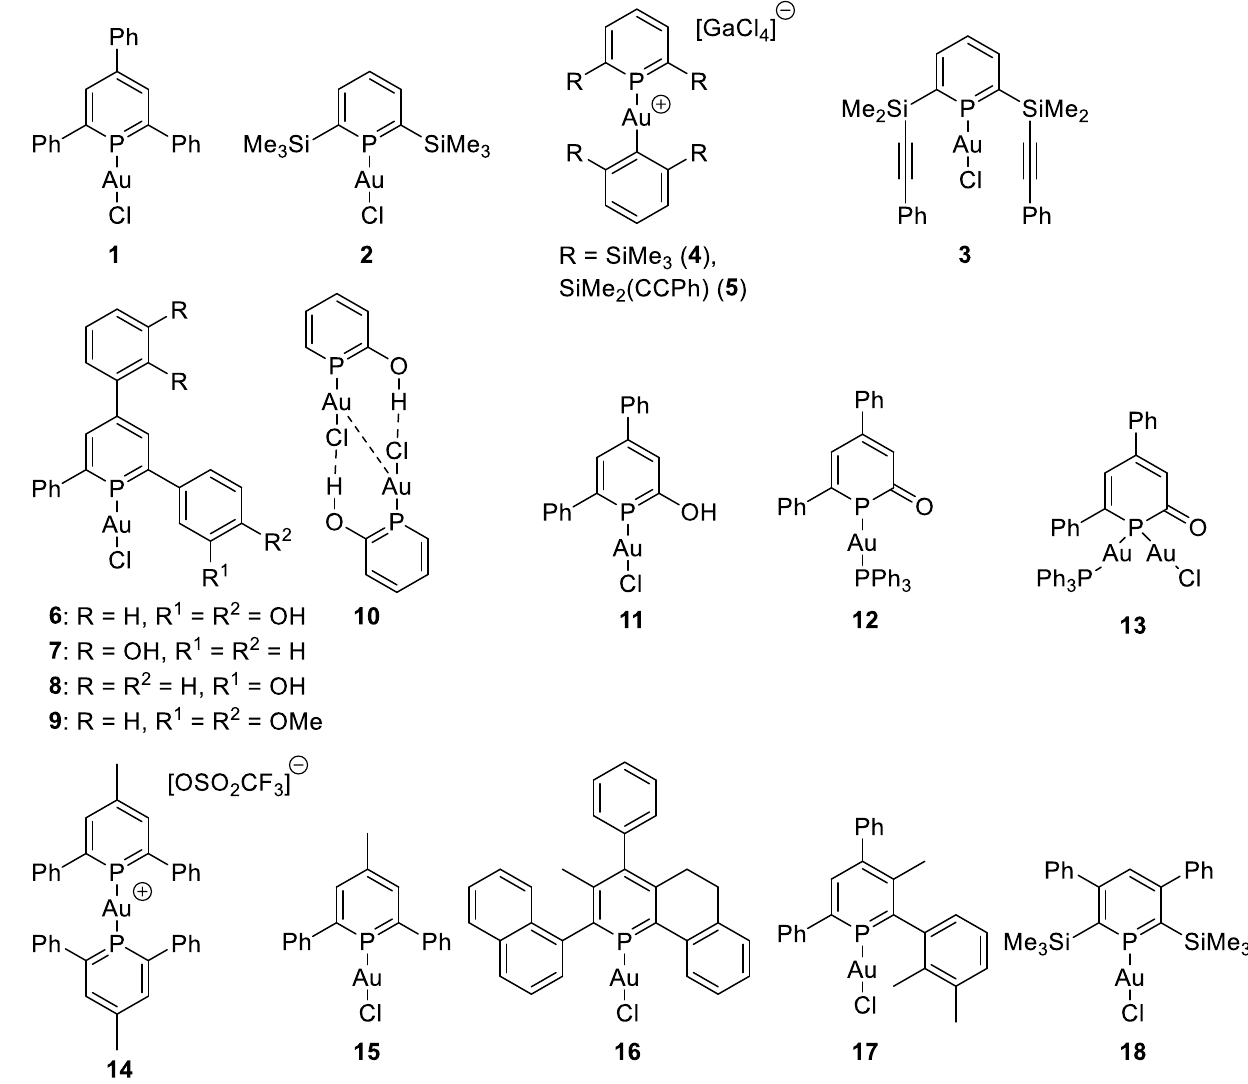
Figure 1. Gold phosphinine complexes.